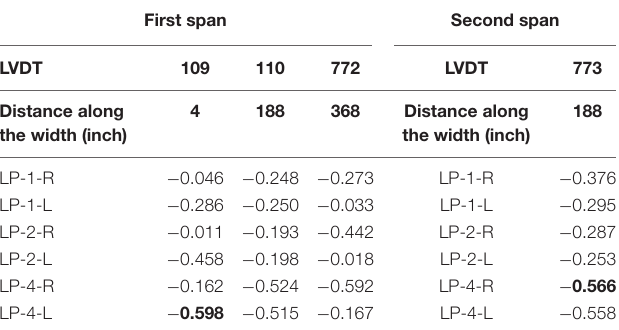
TABLE 4 | Summary of deflections for each static load pattern (mm) (1 inch = 25.4